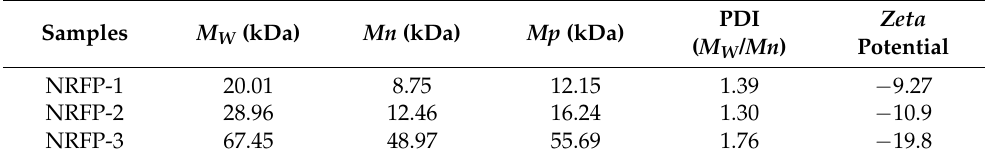
Table 4. Molecular weight distribution of